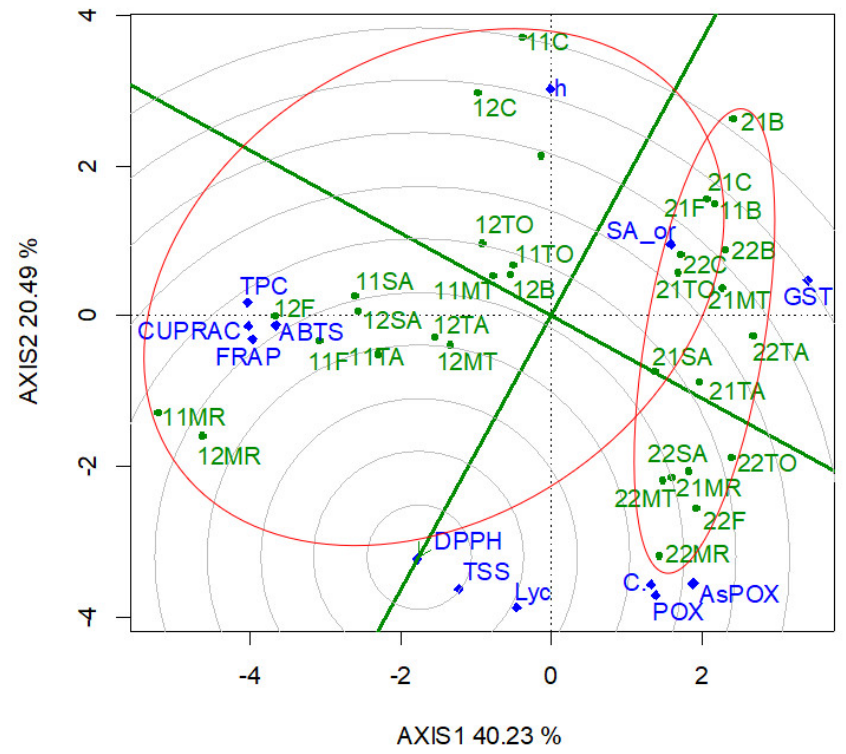
Figure 2. Genotype-focused GGE biplot based on the two-year (2015–2016) phytonutrient dataset of the investigated tomato PGRs. Red oval circles divide data points of different years. Legend: green